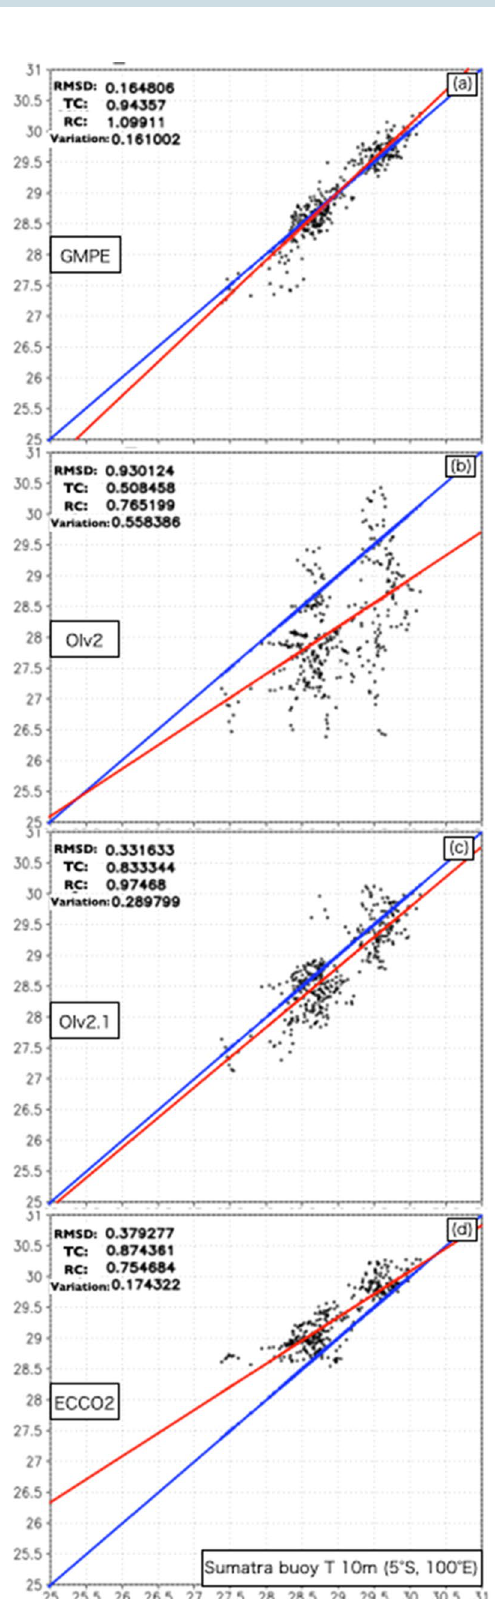
Figure 1. Scatter plots for ( a ) GMPE, ( b) OIv2, ( c ) OIv2.1, and ( d ) ECCO2 at 5° S, 100° E for the period from 6 Dec. 2017–30 Nov. 2018 with respect to the Sumatra buoy. The temporally averaged RMSD, TC, RC, and variance are shown in the top left corner of each panel. The regression line and the line with a slope of 1 are shown by the red and blue lines, respectively. The black box shows the area for averaging RSMD in Fig.